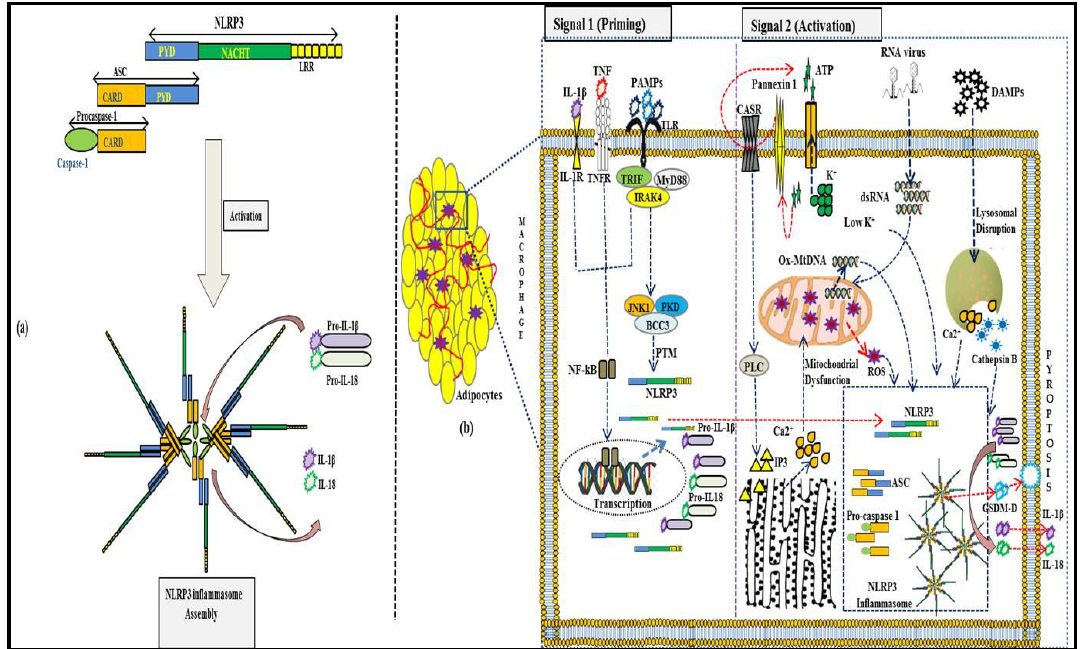
Figure 1. Classical NLRP3-inflammasome activation mediated maturation of pro-inflammatory signals in adipose tissue. ( a ): Individual components of NLRP3 inflammasome. It consists of NLRP3 protein with leucine-rich repeats (LRR), globular NACHT domain, and homologous PYD domain, which interact with PYD of adapter ASC. The CARD domain of ASC allows interaction with pro-caspase-1, which matures into caspase-1 upon NLRP3 inflammasome activation and oligomerization. ( b ): NLRP3 inflammasome activation in adipocyte invading ATM ’ s requires two signals. The first signal involves the priming signal, which is induced by endogenous cytokines or microbial components, such as lipopolysaccharide (LPS), leading to NF- κB -mediated upregulation of NLRP3 and pro-IL- 1β. The second signal triggered by specific stimuli, PAMPs, and DAMPs, results in stresses, such as K + efflux, mitochondrial dysfunction, and lysosomal disruption, which stimulates NLRP3 inflammasome formation. The activation of the NLRP3 inflammasome leads to procaspase-1 self-cleavage, generating active caspase-1, which in turn mediates IL- 1β and IL -18 secretion and pyroptosis.